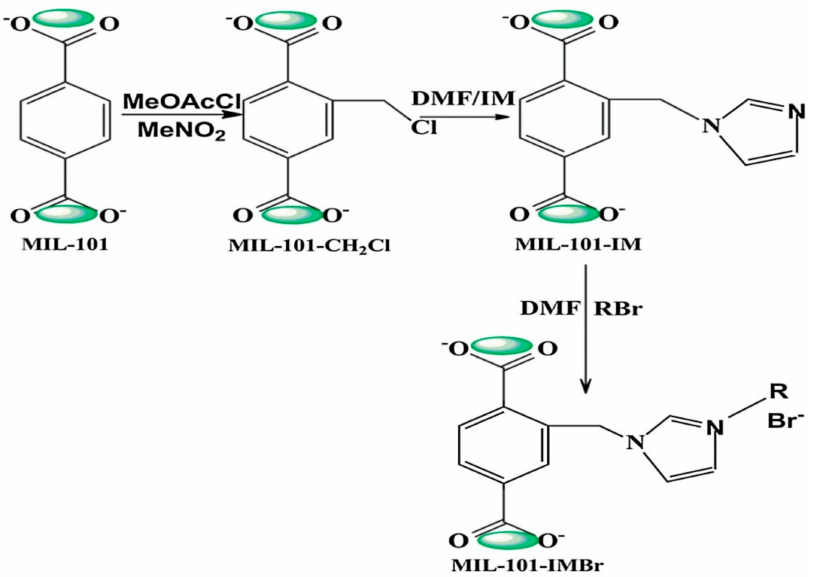
Figure 18. Schematic representation for the synthesis of MIL-101-IMBr. Reprinted with permission from Ref. [160]. Copyright 2018 Elsevier.